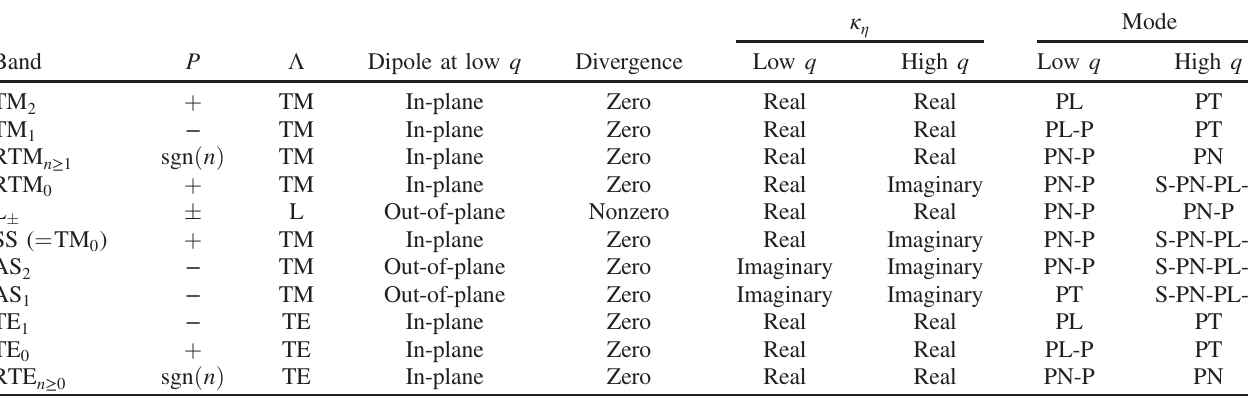
TABLE I. Summary of physical properties for each of elementary excitations. The labels for each band in the first column are consistent with those indicated in Fig. 6. The second and third columns represent the parity P ¼ (cid:3) and the polarization Λ ∈ f TM ; TE ; L g of each mode, respectively. The fourth column indicates the direction of the dipole moments in the insulator at low in-plane wave vector q with respect to the plane parallel to the interfaces. The fifth column shows whether or not the divergence of the electric field is vanishing. The sixth and seventh columns represent whether the longitudinal wave number κ η takes a real value or a purely imaginary value at low and high q , respectively. The subscript η ∈ f q ; n; λ g with λ ¼ ð Λ ; P Þ represents a set of all the variables specifying each eigenmode. The final two columns indicate the physical nature of each hybridized band at low and high q , where we abbreviate elementary excitations as plasmons (PL), photons (PT), phonons (PN), and polaritons (P) and specify surface modes by